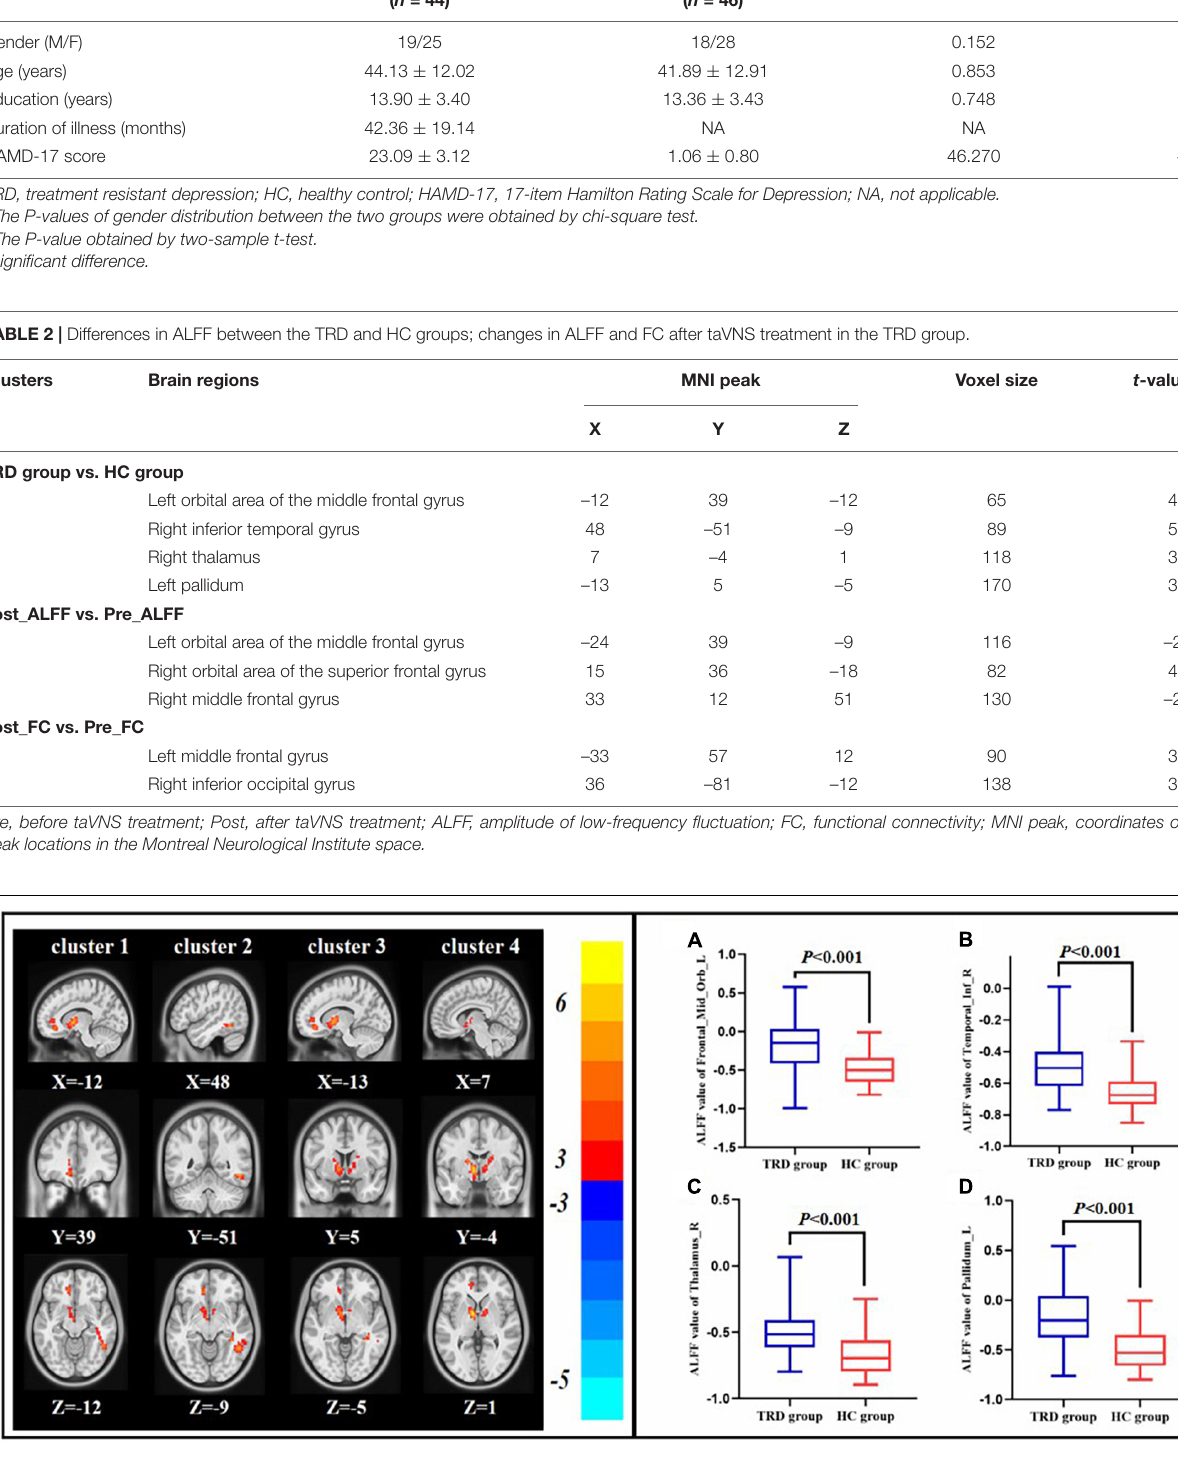
Frontiers in Psychiatry |